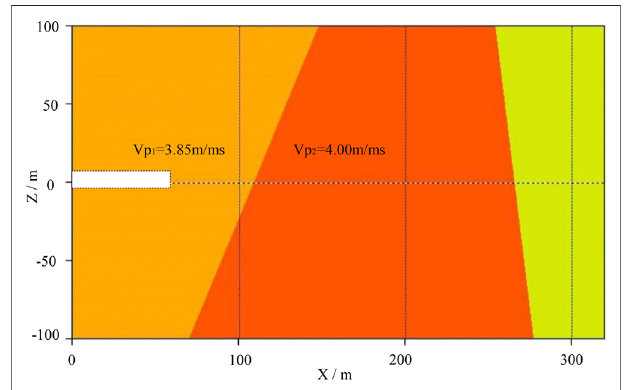
FIGURE 9 | Velocity model of PMVMB method. The rightmost area represents the third layer of the model whose left boundary is de fi ned by Figure 7D . Since there is no re fl ection interface on the rightmost area of the model, no re fl ected signals can be received. Accordingly, background velocity can be used as the velocity in this area because there is no way to solve the velocity of this